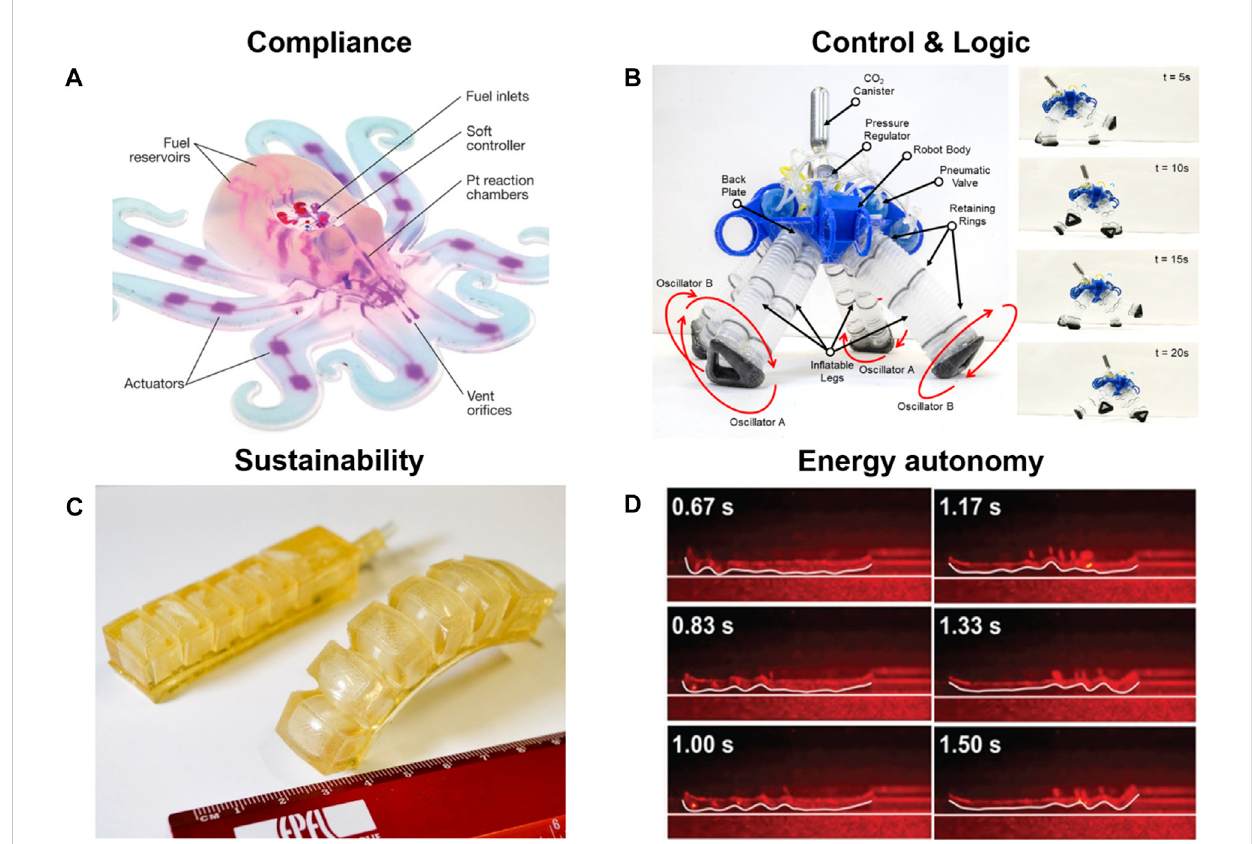
FIGURE 1 Soft robotic examples for electronic free control, energyautonomy,sustainability, andcompliance. (A) As an example ofelectronicfreecontrol, the untethered quadruped utilizes soft pneumatic logic gates set up as oscillators to control movement and object avoidance. From (Drotmann et al., 2021). Reprinted with permission from AAAS. (B) Liquid crystalline elastomer-based crawling robot driven by a laser passing along the robots length. This is an example of energy autonomy as the actuation and motion are generated by structural changes inside the material in reaction to light exposure, and no further energy source is needed. From (Rogó ż et al., 2016). Reprinted with permission from John Wiley and Sons. (C) The gelatin-based 3D printing materials areused as anexample ofbiobased, biodegradable,and sustainable materials. From (Shintake etal.,2017).Reprintedwithpermissionfrom IEEE Proceedings. (D) The fully autonomous and fully fl exible iconic Octobot is the world ’ s fi rst fully fl exible soft robot capable of autonomous movement. From (Wehner et al., 2016). Reprinted with permission from Springer